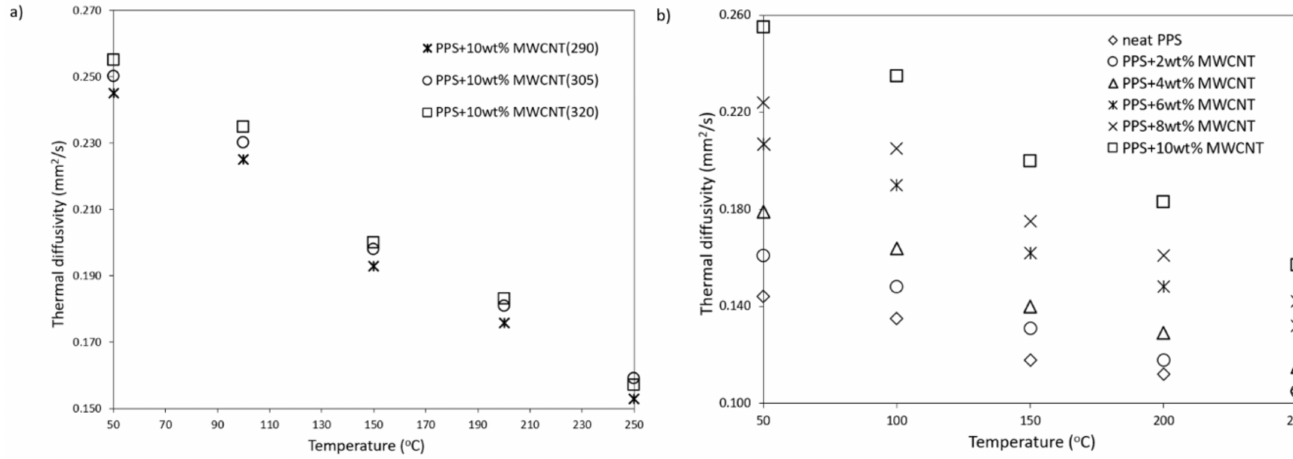
Figure 5. Thermal diffusivity vs. ( a ) temperature of PPS-based composites filled with MWCNT and ( b ) temperature of PPS-based composite manufactured with different